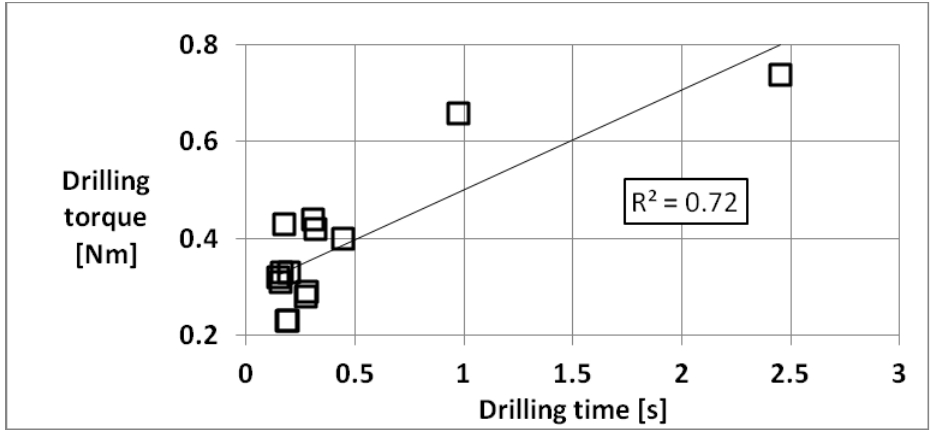
9 Figure 9. The relationship between the averaged time needed to make a 10 mm deep hole (drilling time) and the averaged drilling torque measured during the earlier, significantly reliable machinability testing [12] for all fourteen tested